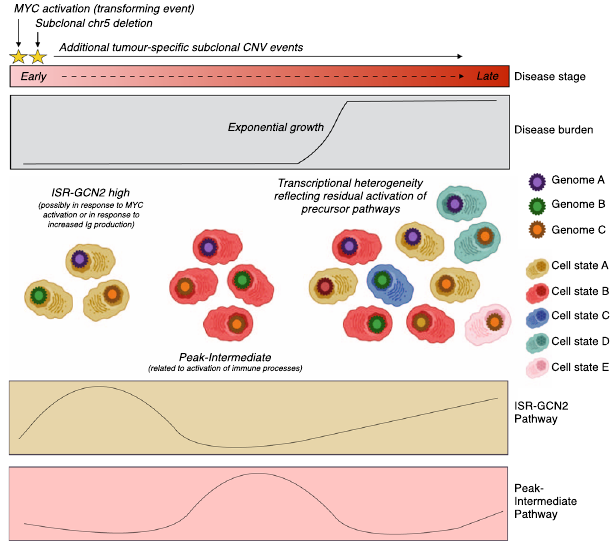
Fig. 5 Proposed model for patterns of tumour heterogeneity during myeloma disease progression in V κ *MYC mouse model. Graphics created in part using